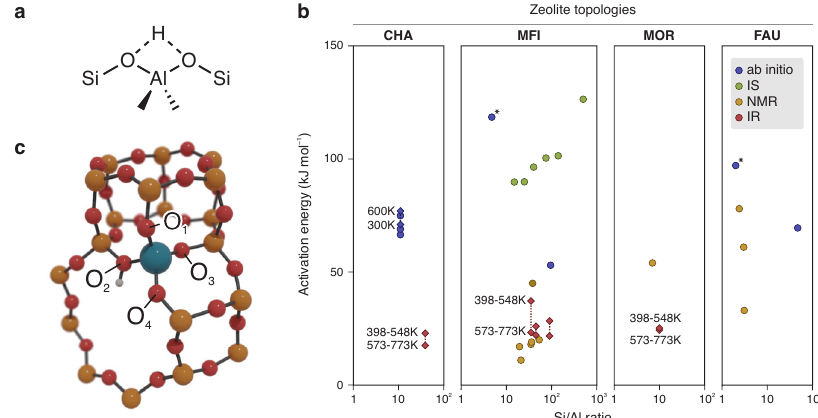
Fig. 1 | Poor agreement is found in the available literature for the activation energy of the proton hopping reaction. a Schematic depiction of the proton hopping reaction. b Activation energy for the proton hopping process as function oftheSi/Alratioformultiplezeolites,asderivedfromtheavailableliterature 75 .The data was obtained from ab initio calculations (blue, the points with an asterisk correspondtoclustercalculationsand,therefore,theSi/Alratioismeaningless)or IR (red), NMR (yellow) and IS (green) spectroscopies. If more values are available